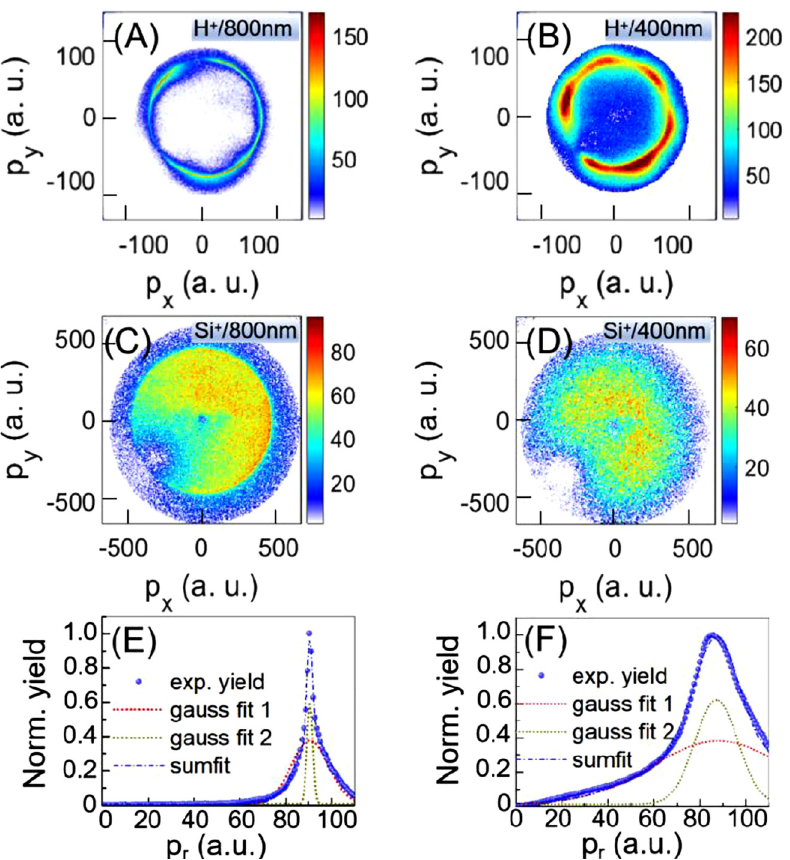
Figure 4: (A) The momentum distribution of the H + ion emission from the nanoparticle system irradiated at the excitation intensity of100TW/cm 2 at800nm.Theblackandred arrows indicate the laser propagation and polarization directions, respectively. (B) Similar to (A) but for the excitation at 400 nm. (C) and (D) are similar to those of (A) and (B) but are obtained for the Si + ions. (E) and (F) are the radial momentum distributions of the H + ions (shown in A and B) fi tted by two Gaussian functions. The blue scattered bullets show the experimentalyield.Thebluedash-dotcurve representsthe2-Gaussian fi ttingresult.The red and dark yellow dashed curves are the separated Gaussian fi tting results, repre- senting the plasma expansion and the shock wave,